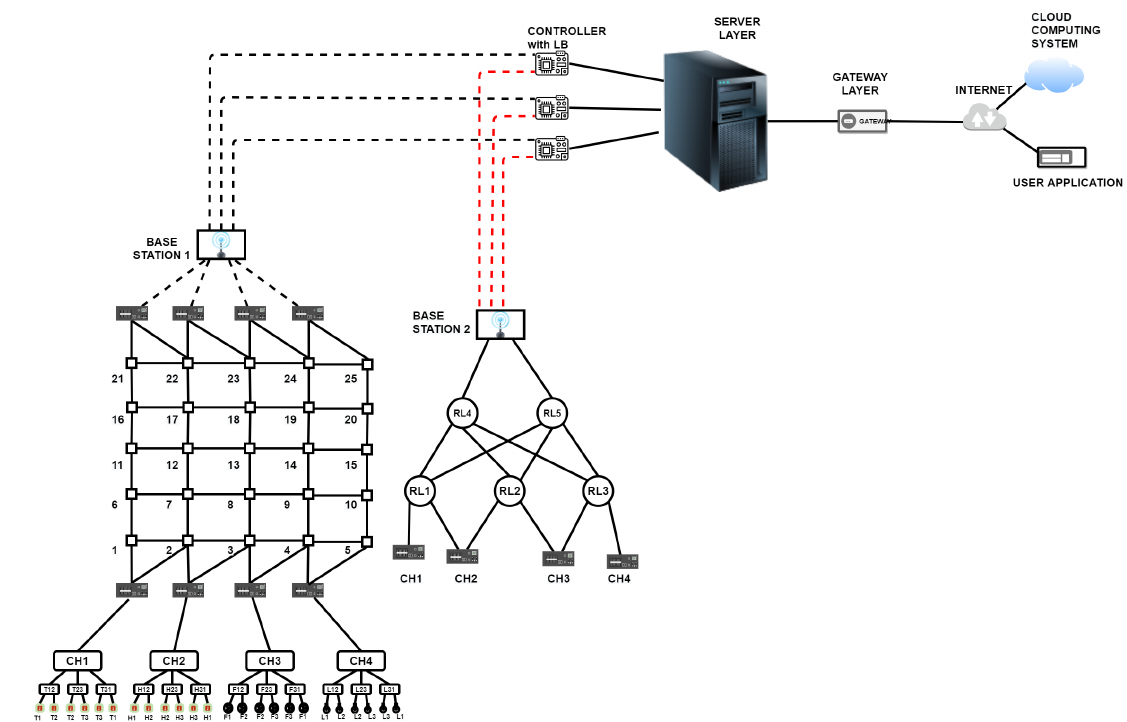
The sample IoT network has been modified, as shown in Figure 4.